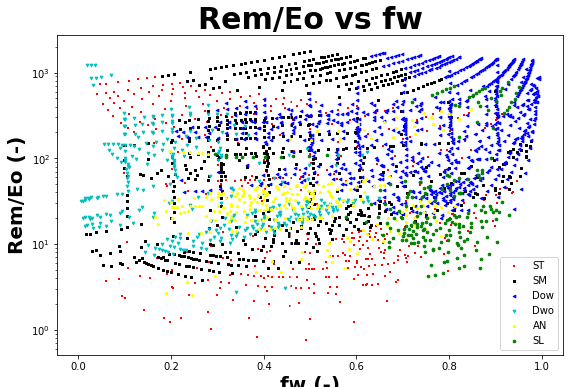
Figure 6. The ratio of mixture Reynold number to Eötvös number (Re m /Eo) versus water fraction (f w ) for the gathered published experimental datasets. Note: data from [3,11,22,38,41,52,55–58]. Data points denoted with red squares, black rectangles, blue triangle_left, cyan triangle_down, yellow circle and green star represent stratified flow (ST), stratified mixed flow (SM), dispersed oil-in-water flow (Do/w), dispersed water-in-oil flow (Dw/o), annular flow (AN) and slug flow (SL), respectively.